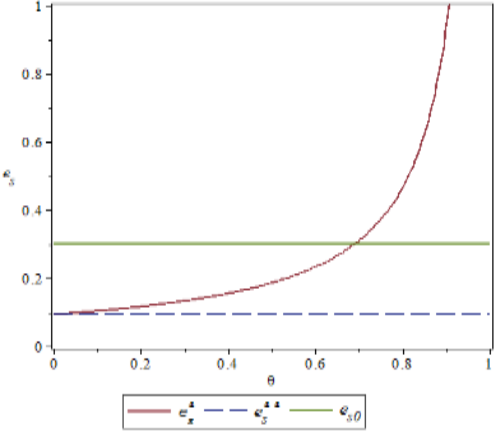
Figure 2. E ff ect of manufacturer’s behavior θ on the supplier green Figure 2. Effect of manufacturer’s behavior θ on the supplier green index.